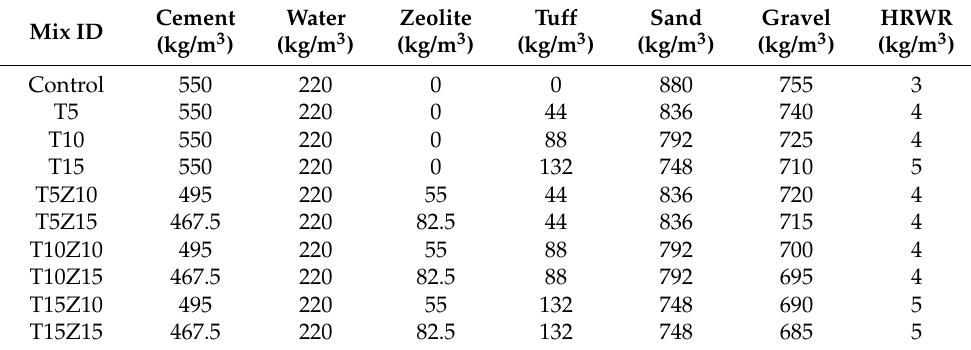
Table 3. Mixture proportions of the